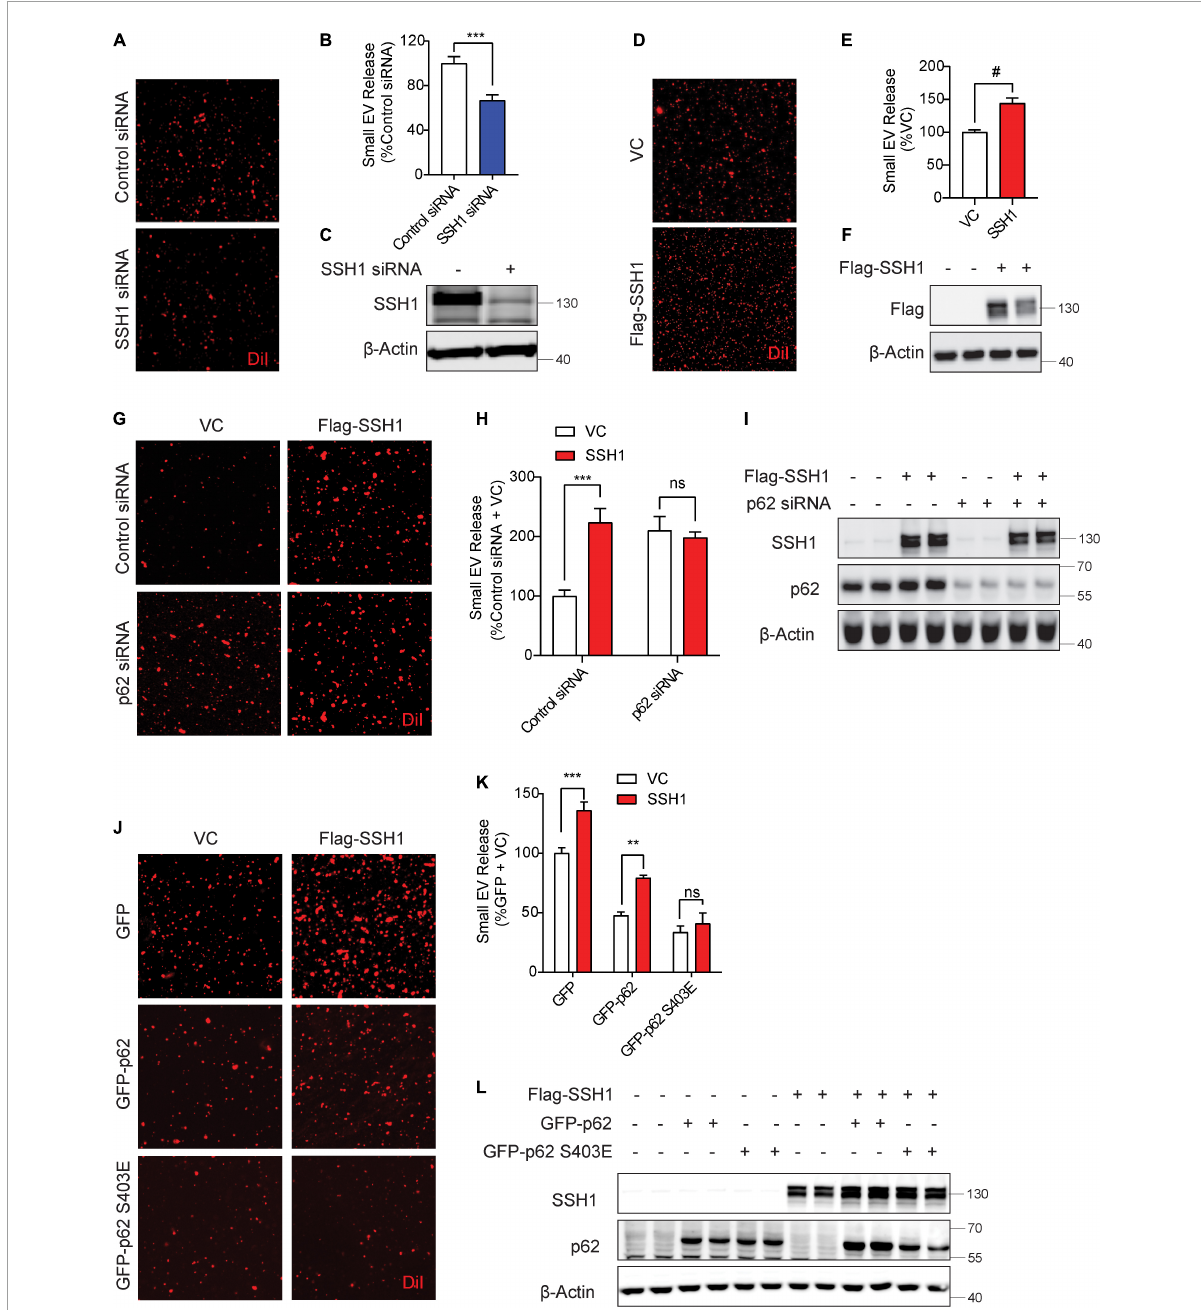
FIGURE3 Slingshot homolog-1 (SSH1)-mediated p62 inhibition at pSer403 increases small EV secretion. (A) Representative images of DiI-stained small EVs secreted from NIH3T3 cells transfected with control siRNA or SSH1 siRNA. (B) Quantification of secreted small EVs for (A) . Data are presented as means ± SEM. n = 3 independent experiments, t -test, *** P = 0.0005. (C) Representative immunoblots for SSH1 and β -Actin protein levels in cell lysates for (A) . (D) Representative images of DiI-stained small EVs secreted from NIH3T3 cells expressing VC or Flag-SSH1 (E) Quantification of secreted small EVs for (D) . Data are presented as means ± SEM. n = 3 independent experiments, t -test, # P < 0.0001 (F) Representative immunoblots for Flag and β -Actin protein levels in cell lysates for (D) . (G) Representative images of DiI-stained small EVs secreted from NIH3T3 cells co-transfected with VC or Flag-SSH1 and control siRNA or p62 siRNA. (H) Quantification of secreted small EVs for (G) . Data are presented as means ± SEM. n = 3 independent experiments, 2-way ANOVA, followed by Sidak’s post-hoc , *** P = 0.0004. n.s. = not significant. (I) Representative immunoblots showing SSH1, p62, and β -Actin protein levels in cell lysates for (G) . (J) Representative images of DiI-stained small EVs secreted from NIH3T3 cells co-transfected with VC or Flag-SSH1 and GFP, GFP-p62, or GFP-p62 S403E. (K) Quantification of secreted small EVs for (J) . Data are presented as means ± SEM. n = 3 independent experiments, 2-way ANOVA, followed by Sidak’s post-hoc , *** P = 0.0007, ** P = 0.001. n.s. = not significant. (L) Representative immunoblots for SSH1, p62, and β -Actin protein levels in cell lysates for (J)